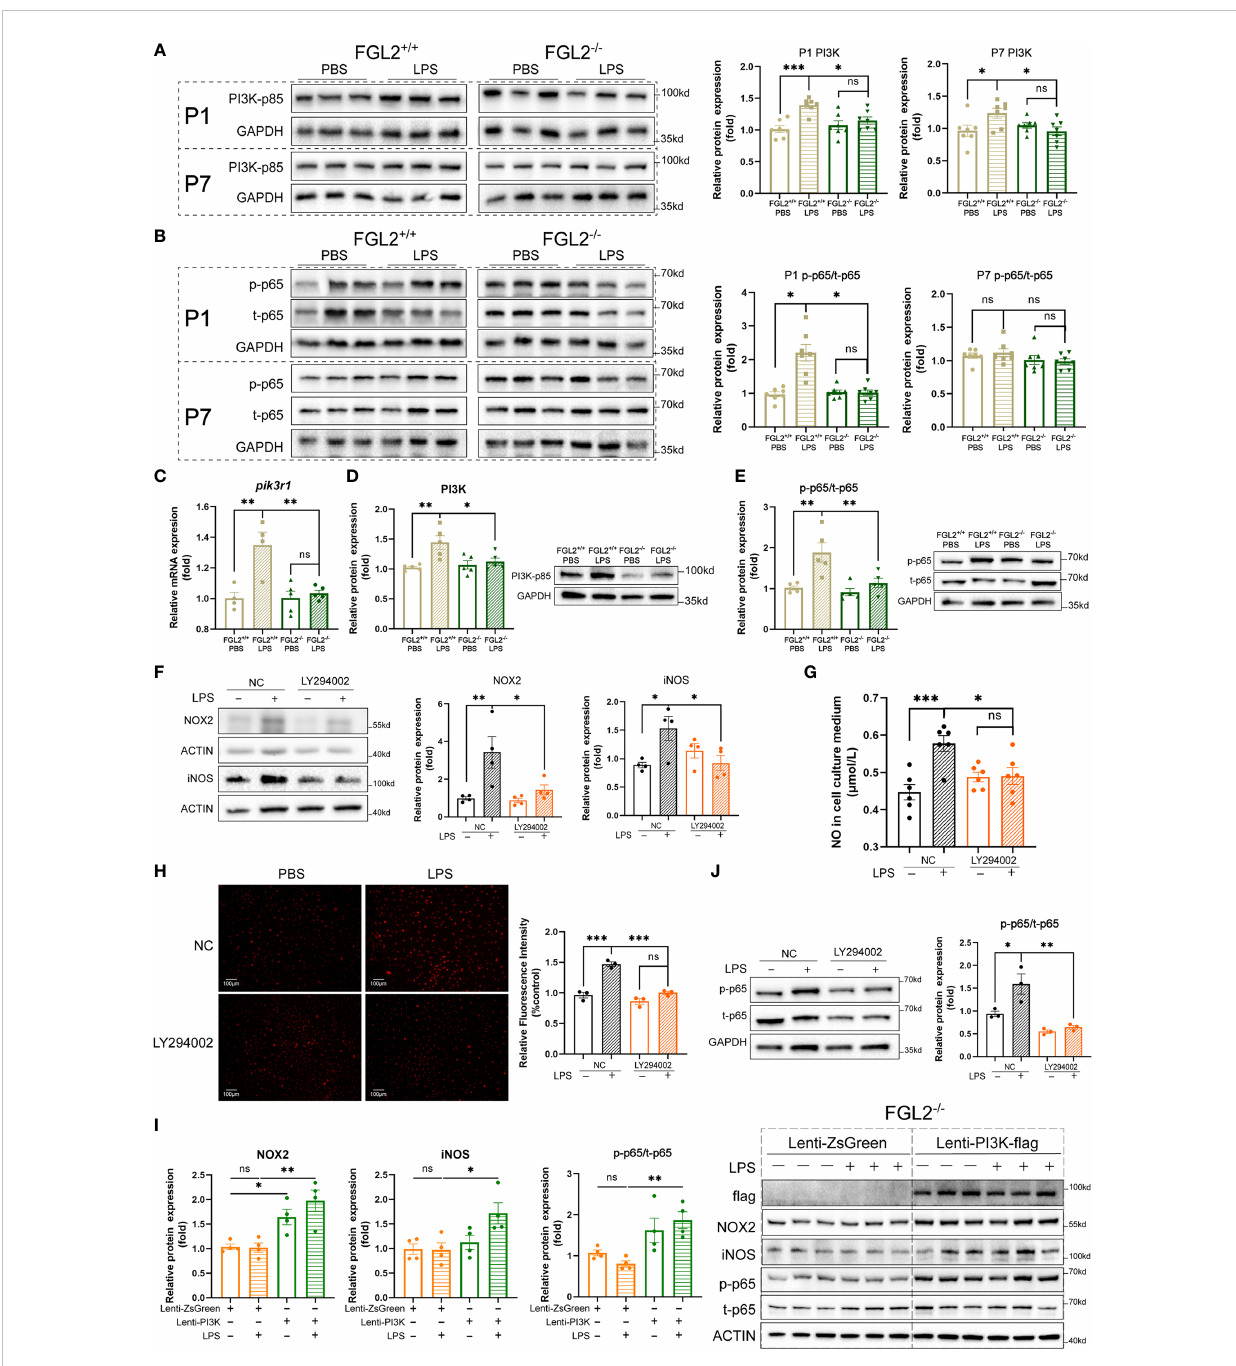
FIGURE 5 FGL2 de fi ciency alleviated endothelial oxidative stress via inhibiting the activation of PI3K/NF- k B pathway. (A) The protein expressions of PI3K-p85 in brain at P1 and in cortex at P7 ( n = 7). (B) The protein expressions of NF- k B p65 and its phosphorylated form in brain at P1 and in cortex at P7 ( n = 7). (C) The mRNA level of pik3r1 in BMECs ( n =4:4:5:5). FGL2 +/+ and FGL2 -/- BMECs were treated with LPS (5 m g/ml) or PBS for 24 h. (D) The protein expression of PI3K-p85 in BMECs ( n = 5). (E) The protein expressions of NF- k B p65 and its phosphorylated form in BMECs ( n = 5). (F) The protein levels of NOX2 and iNOS in LY294002-pretreated BMECs ( n = 4). Before LPS (5 m g/ml) stimulation for 24 h, FGL2 +/+ BMECs were pretreated with or without LY294002 (20 m M) for 2 h. (G) The concentration of NO in culture mediums of LY294002-pretreated BMECs ( n = 6). (H) The levels of ROS by DHE staining in LY294002-pretreated BMECs ( n = 3). Representative images were shown, and quantitative results were normalized to controls. Scale bar=100 µm. (I) The protein expressions of fl ag, NOX2, iNOS, p-p65, and t-p65 in FGL2 -/- BMECs ( n = 4). FGL2 -/- BMECs were infected by Lenti-PI3K- fl ag or Lenti-ZsGreen for 48 h before treatment of LPS (5 m g/ml) for 24 h. (J) The protein levels of p-p65 and t-p65 in LY294002- pretreated BMECs ( n = 3). The data was expressed as mean ± SEM and was the representative of at least three independent experiments. Statistical differences were assessed by unpaired two-tailed Student ’ s t test for two groups and one-way ANOVA with Tukey ’ s post-hoc test for four groups. Welch ’ s ANOVA with Dunnett ’ s T3 post-hoc test was used to compare the protein expression of p-p65/t-p65 among four groups in brain at P1. ns P >0.05, * P <0.05, ** P <0.01, *** P